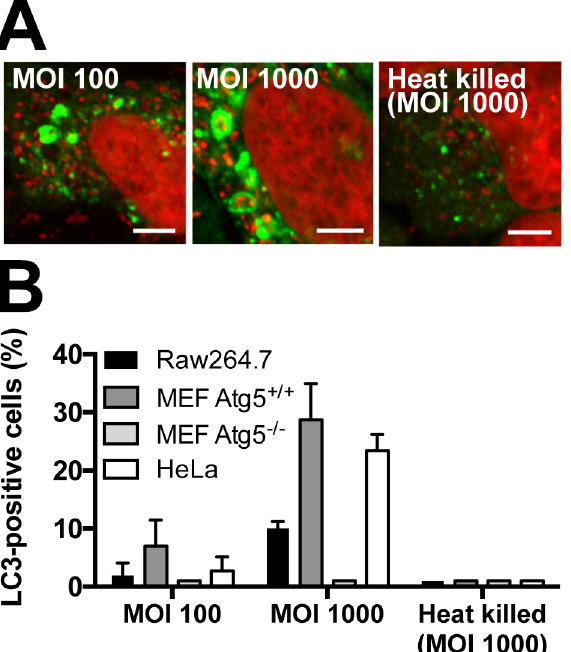
Fig 3. Induction of LC3-positive P . acnes in different conditions. (A) Confocal microscopic images of P . acnes -infected HeLa cells at 8 h postinfection. HeLa cells were infected by viable P . acnes at MOI 100 and 1000 or by heat-killed P . acnes at MOI 1000. Scale bar: 5 μ m. (B) Frequency of cells with LC3-positive vacuoles containing P . acnes at 8 h postinfection. Raw264.7, MEF (including Atg5 -/- cells) and HeLa cells were infected by viable P . acnes at MOI 100 and 1000 or by heat-killed P . acnes at MOI 1000. Data are representative of at least three independent experiments. Black bars; means +